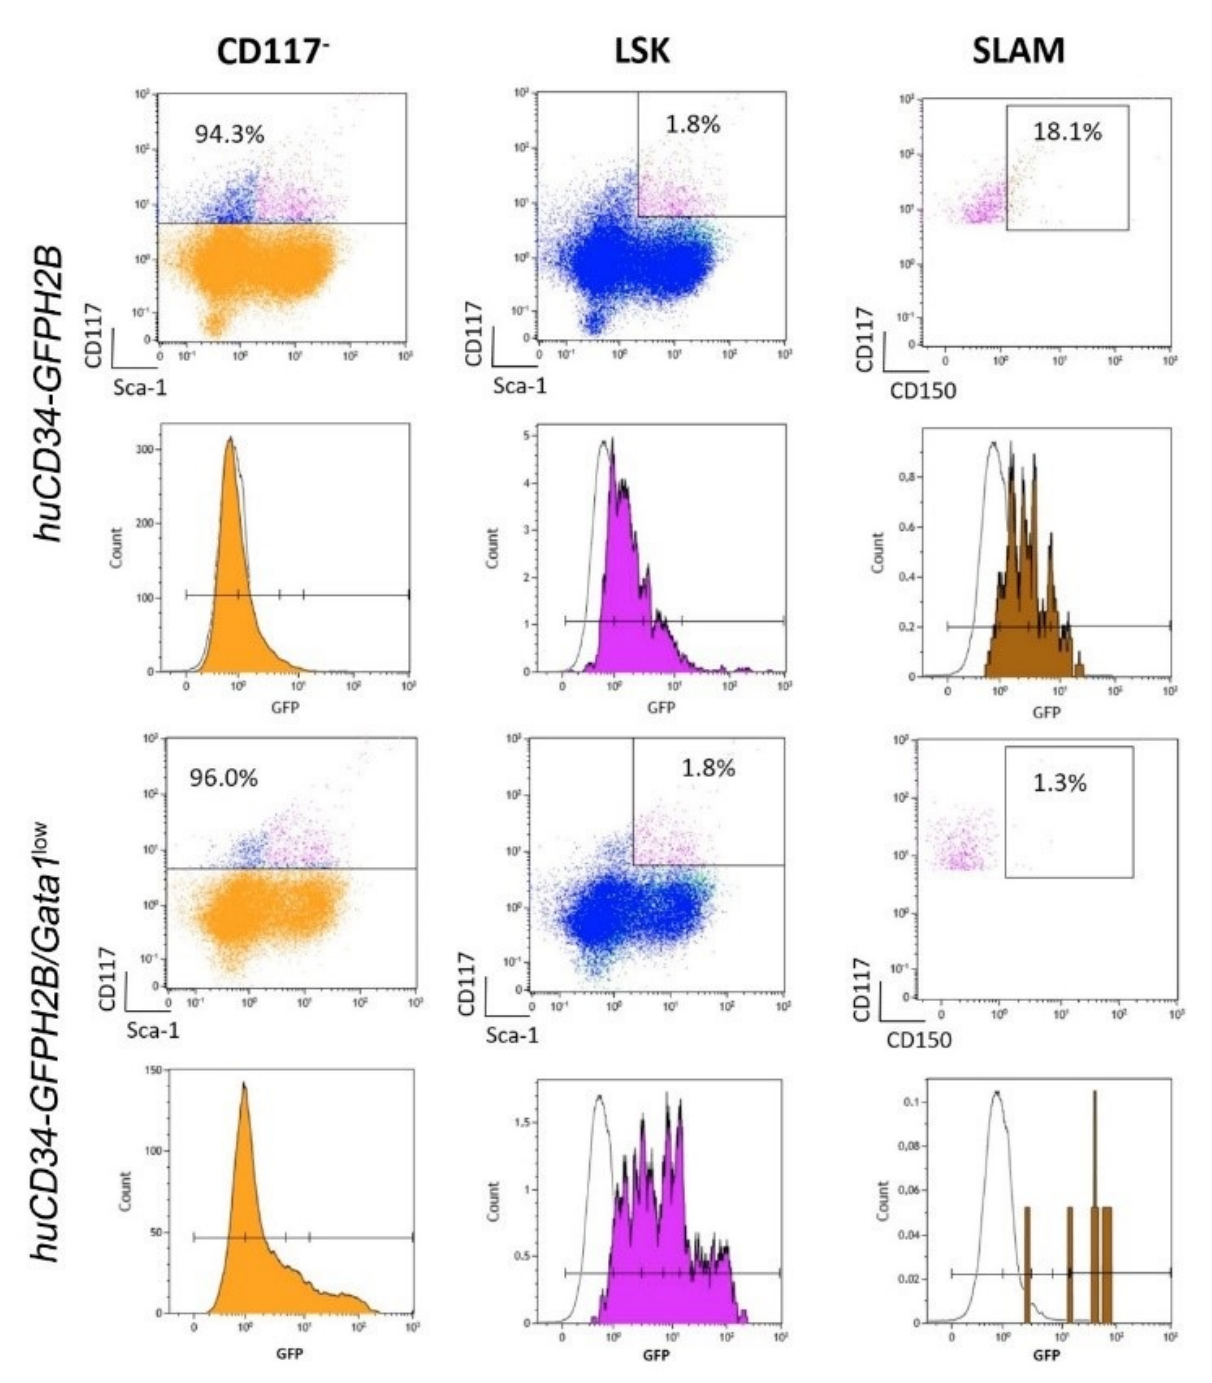
Figure 8. By flow cytometry, in the bone marrow of wild-type mice, GFP is expressed only by cells in the LSK gate, while in that from Gata1 low mice, GFP is expressed both by non-LSK and LSC cells. Scatter plots of bone marrow cells from representative huCD34-GFPH2B and huCD34- GFPH2B/Gata1 low littermates showing the gates used to identify cKIT − cells (orange events), LSK (purple events), and SLAM (brown events) cells, as indicated. The intensity of the GFP expressed in the different populations is shown as color-coded histograms below each panel. The dotted histogram included in each panel indicates the signal in the GFP channels from the corresponding cells from the bone marrow of hCD34 and hCD34/Gata1 low mice, used as negative controls. Abbreviations: CD117: cluster of differentiation 117 which recognize cKIT, the receptor for stem cell factor; LSK: cells that do not express lineage markers but express cKIT and Sca1; SLAM: LSK which also express markers of the signaling lymphocyte activation molecules (SLAM) family. By confocal microscopy, cells expressing GFP were clearly detectable in the bone marrow from both huCD34-GFPH2B and huCD34-GFPH2B/Gata1 low littermates (Figures 9 and 10). Stacking analyses indicated that in wild-type mice, GFP was mostly detectable in small cells where it was localized in the nucleus and in very few large cells where it was localized in the cytoplasm (Figure S8A, Supplementary Materials). GFP was mostly local- ized in the nucleus of small cells also in the bone marrow from huCD34-GFPH2B/Gata1 low mice but, in contrast with huCD34-GFPH2B mice, in this case the GFP was localized in the cytoplasm of a great number of large cells that had the morphology of macrophages (Fig- ure S8B, Supplementary Materials, and data not shown). These results suggest that the large proportion of huCD34-GFPH2B/Gata1 low cKIT − bone marrow cells that had been found to express GFP by flow cytometry (Figure 8) are likely macrophages that have phag- ocytized the malignant HSC which had likely died by apoptosis induced by the proin- flammatory environment of the huCD34-GFPH2B/Gata1 low bone marrow [66]. Using these data as a foundation, we determined the localization of small GFP- tagged cells (which represent long- and short-term repopulating HSC and multilineage progenitor cells) within the bone marrow architecture of huCD34-GFPH2B and huCD34- GFPH2B/Gata1 low mice (Figures 9 and 10). In the femur from old wild-type mice, GFP- tagged cells were localized either in clusters in the epiphysis of the femur or in the diaph-